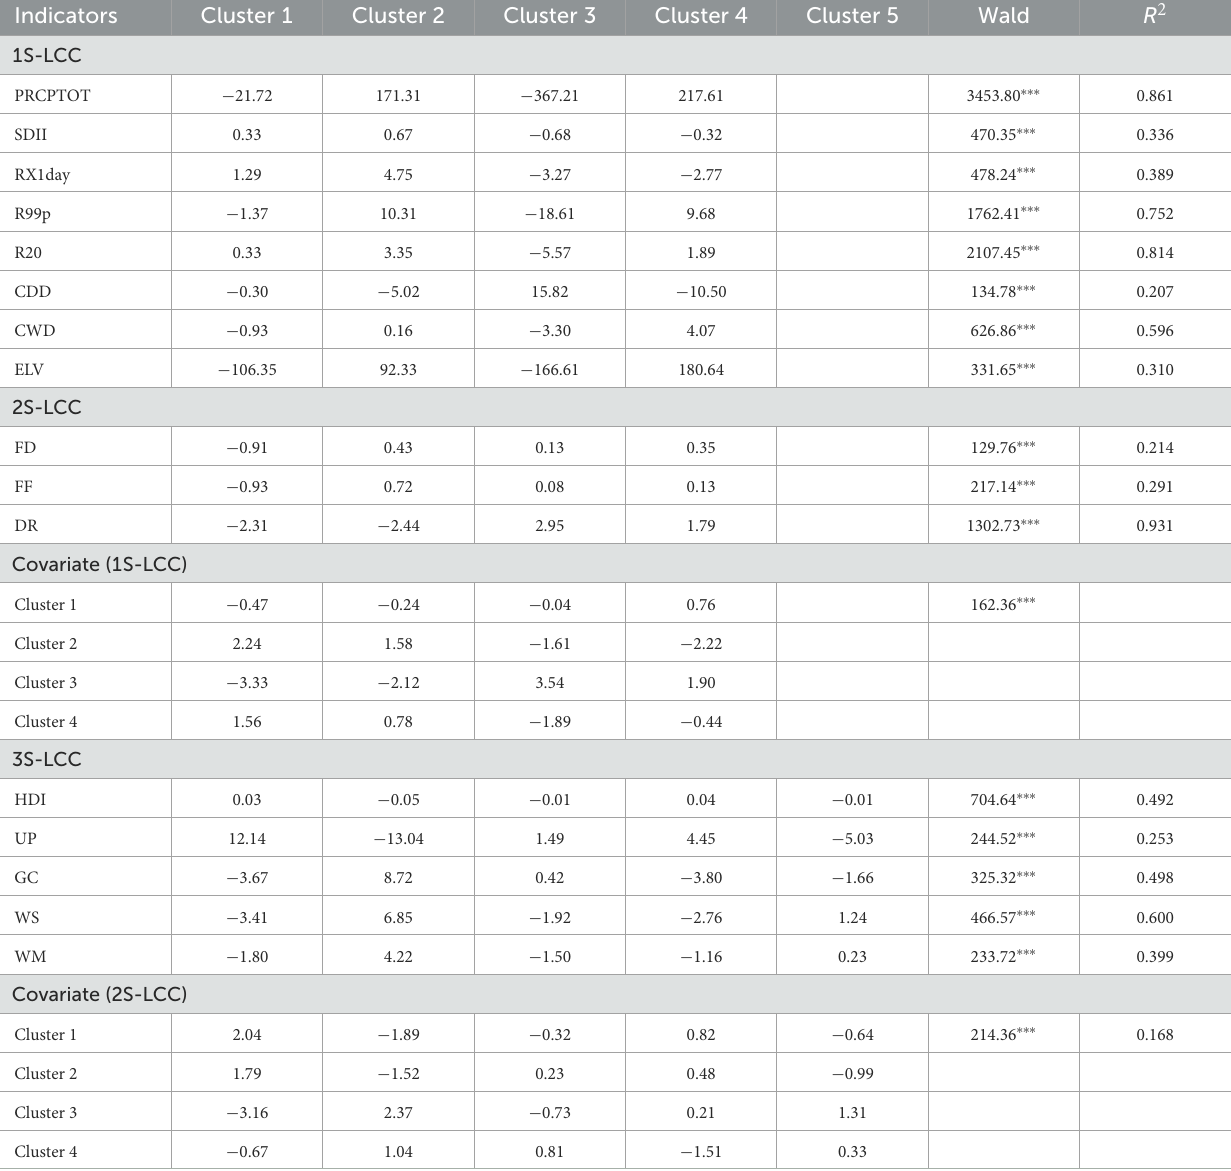
TABLE 2 Linear projection parameter estimates regarding the latent class profiles of extreme rainfall events, rainfall-related disasters, and sociodemographic attributes in Minas Gerais, Brazil. Indicators